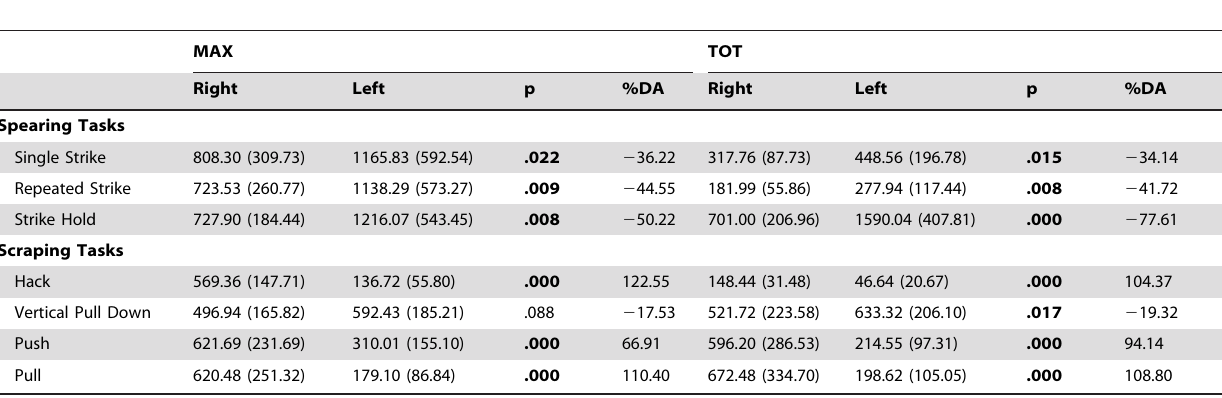
Table 2. Bilateral pectoralis major maximum (MAX) and total (TOT) muscle activity for all scraping and spearing tasks.